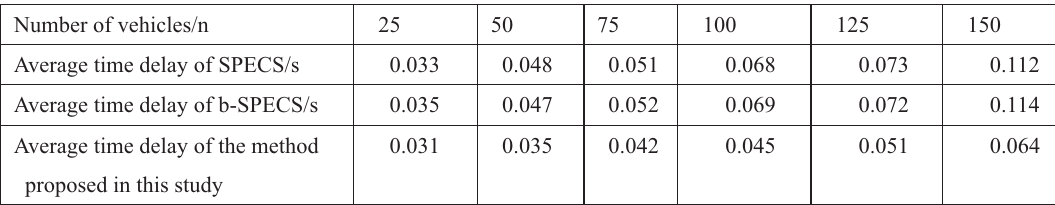
Table 3 . Influence of the number of vehicles on the average time delay ! Table 3. Influence of the number of vehicles on the average time delay